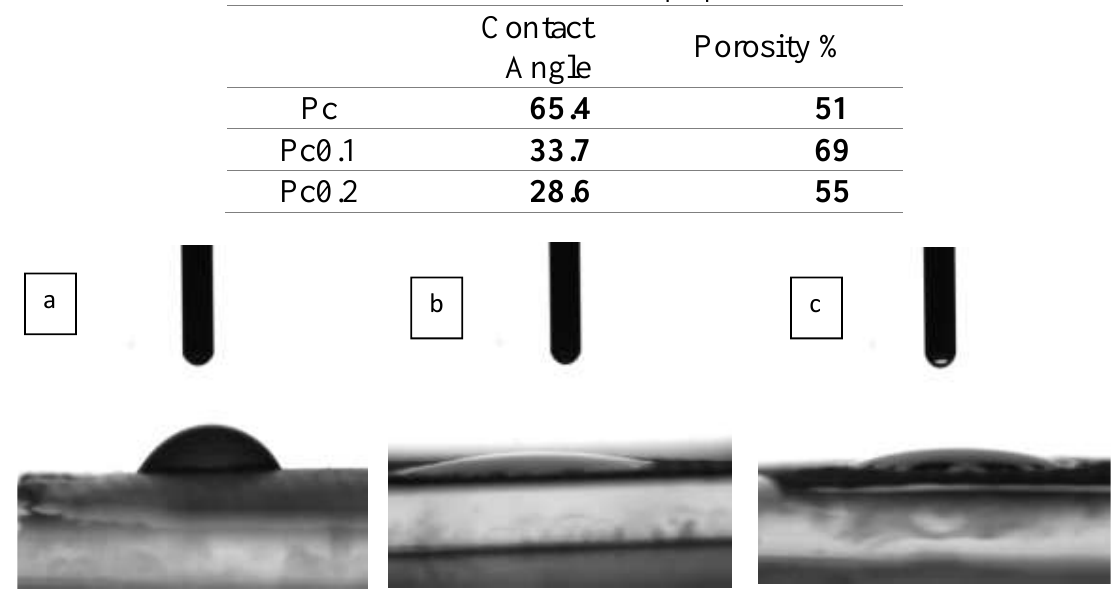
Table 4: Effect of TiO concentration on the properties of PSF substrates. 2